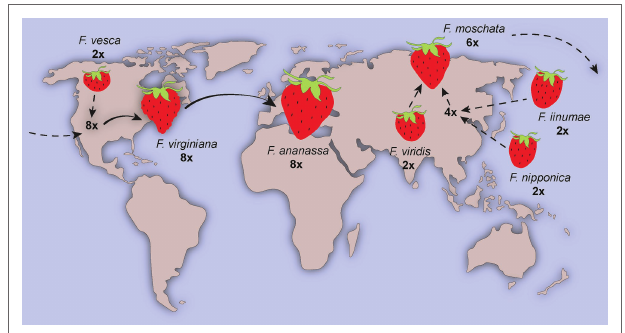
FIGURE 4 | The origin of strawberry. Strawberry is an allo-octoploid originated from multiple hybridization events in Eurasia and America. Modern variety Fragaria × ananassa resulted from cross between two octoploid genotypes Fragaria virginiana and Fragaria chiloensis . Figure adapted from Bertioli